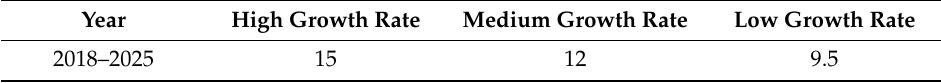
Table 3. Annual average growth rate of living consumption level from 2018 to 2025 (%).